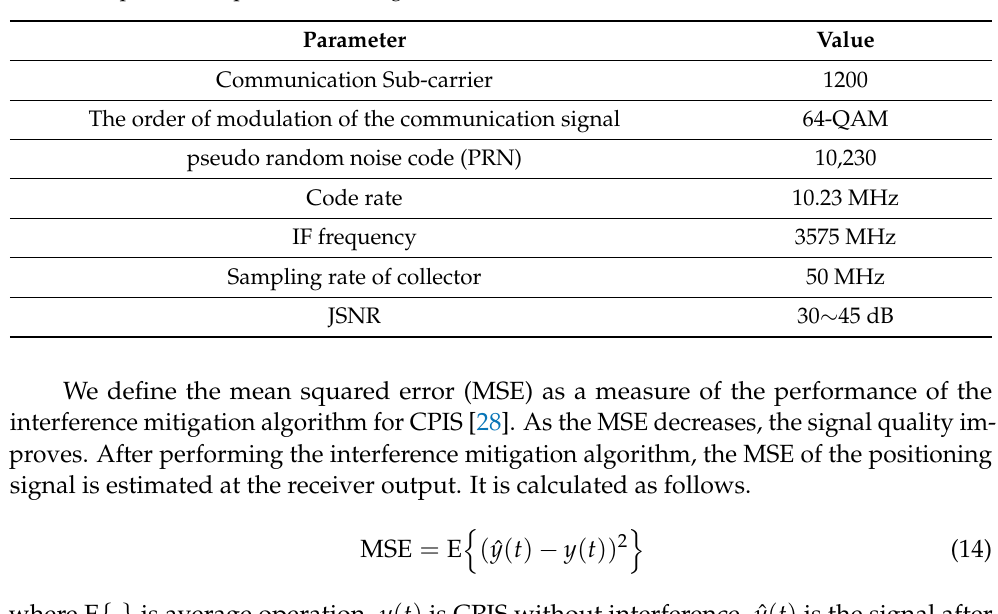
Figure 6. Test environment. Table 1. Experimental parameter